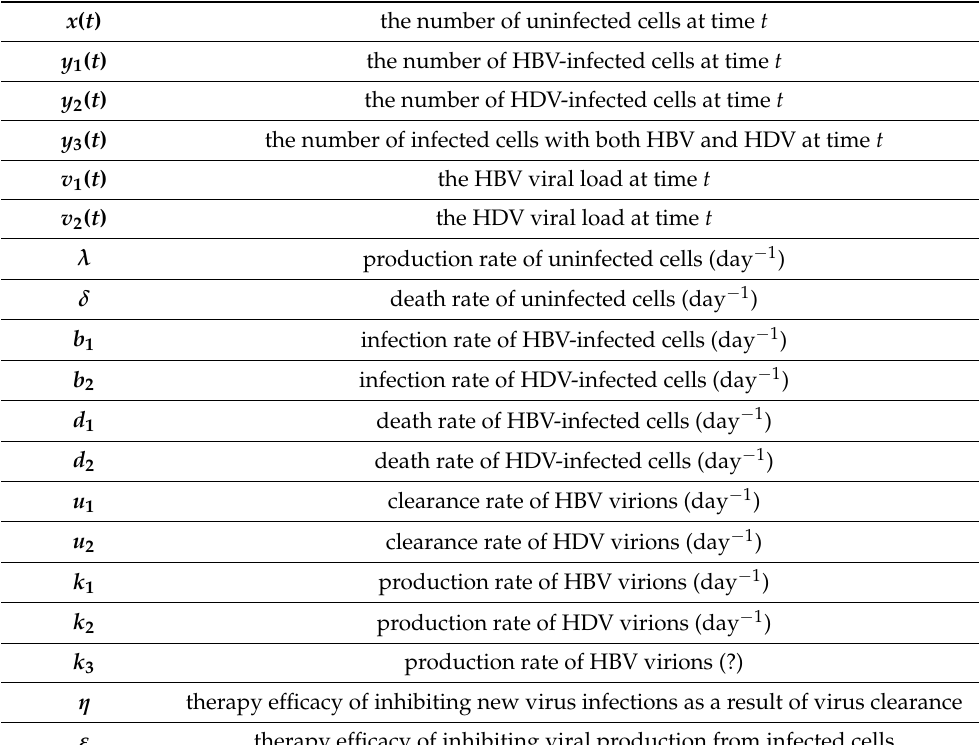
Table 1. The variables and the parameters in the model of de Sousa and Cunha [12]. x ( t ) the number of uninfected cells at time t y 1 ( t